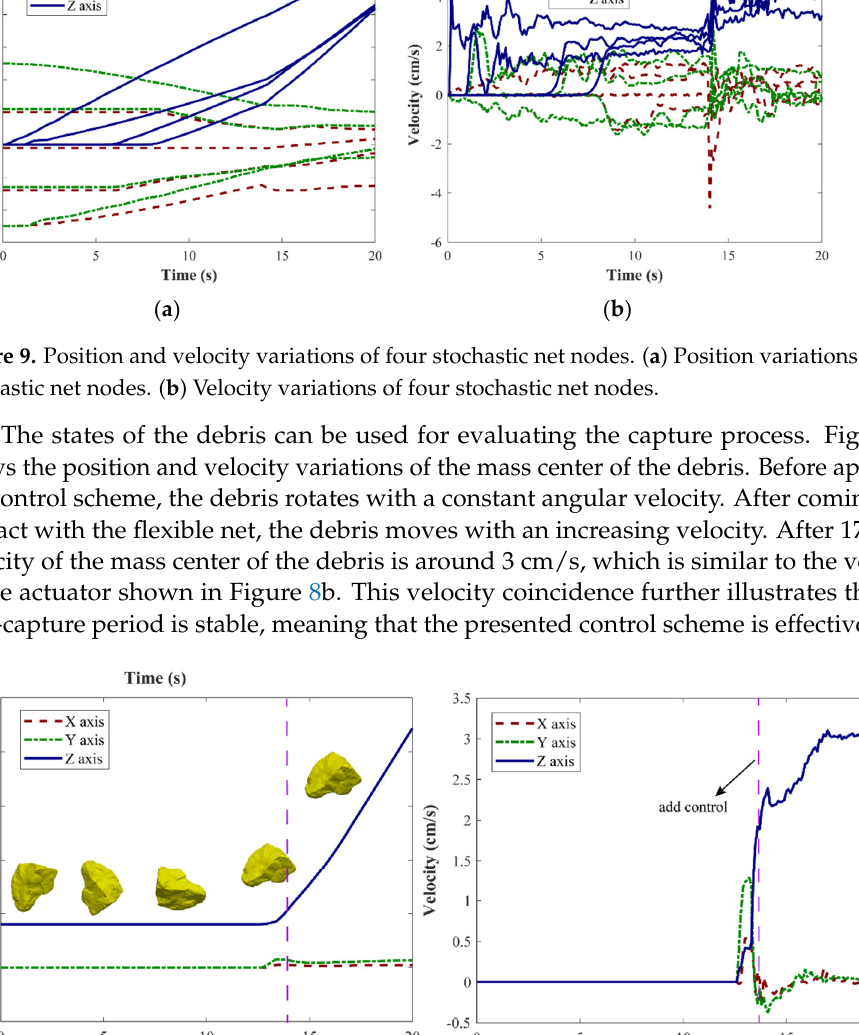
Figure 11. The angular velocity variations of the debris. Contact forces can reflect the safety of the flexible net and the stability of the capture process. Figure 12 shows the maximum contact force at each time step. From Figure 12, we can see that the maximum contact force is smaller than 1 N, which implies that the flexible net is safe after the collisions with the debris. The contact positions are distributed along the edges of the debris, and Figure 12 shows that the contact forces decrease throughout the capture process, which means that the capture process becomes more and more stable. ( a ) ( c ) Figure 12. Contact positions on the debris. ( a ) 13.7 s, ( b ) 17 s, and ( c ) 20 s. Figure 13 shows the control forces of the first actuator. The maximum control force is much smaller than the allowable value of 100 N. The control forces hardly change after 15.7 s and their values are very small when maintaining the trajectory of the actuator, which implies that a stabilized configuration of the flexible net has been achieved.